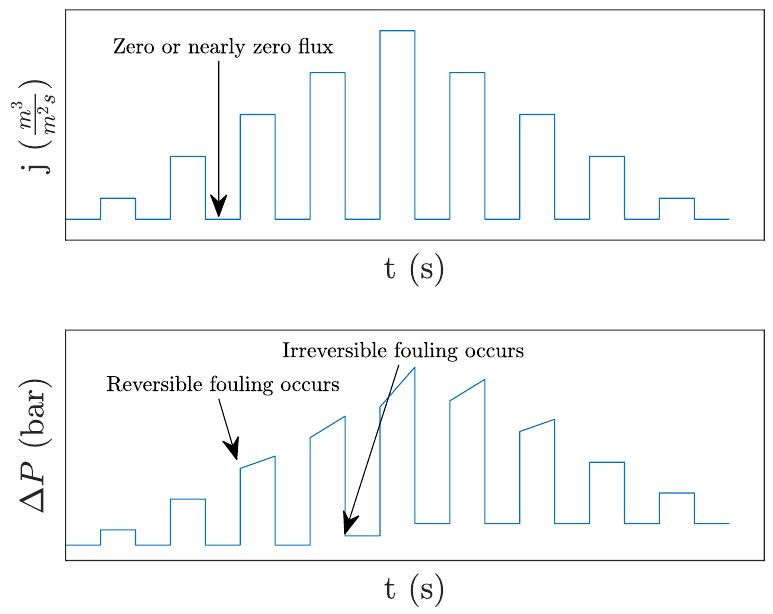
Figure 5. Concept illustration of the modified flux-stepping